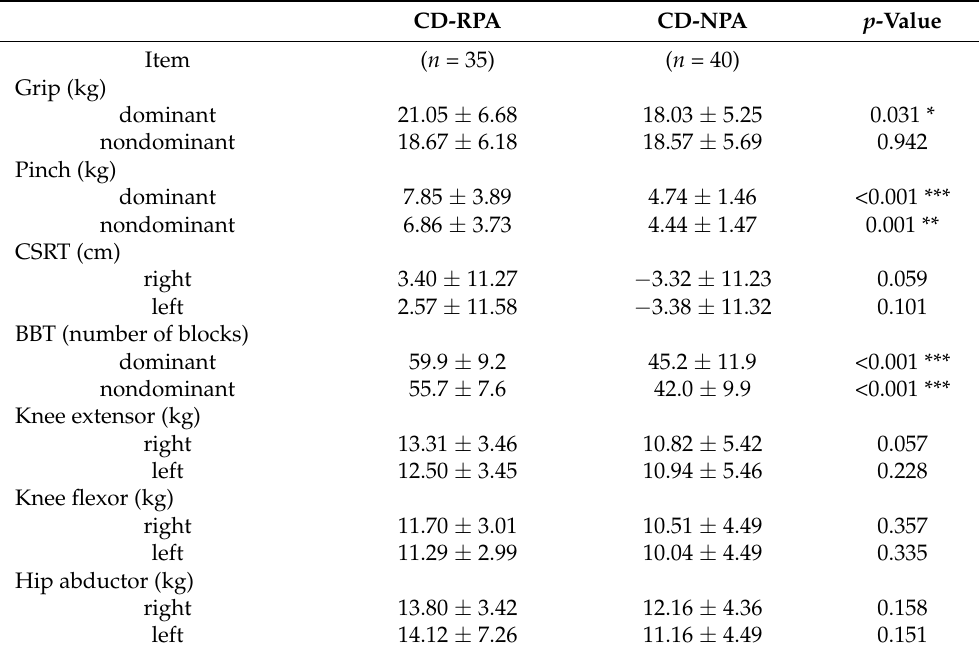
Table 3. Comparison of physical performances between the RPA and the NPA subgroups in CD group. CD-RPA CD-NPA p